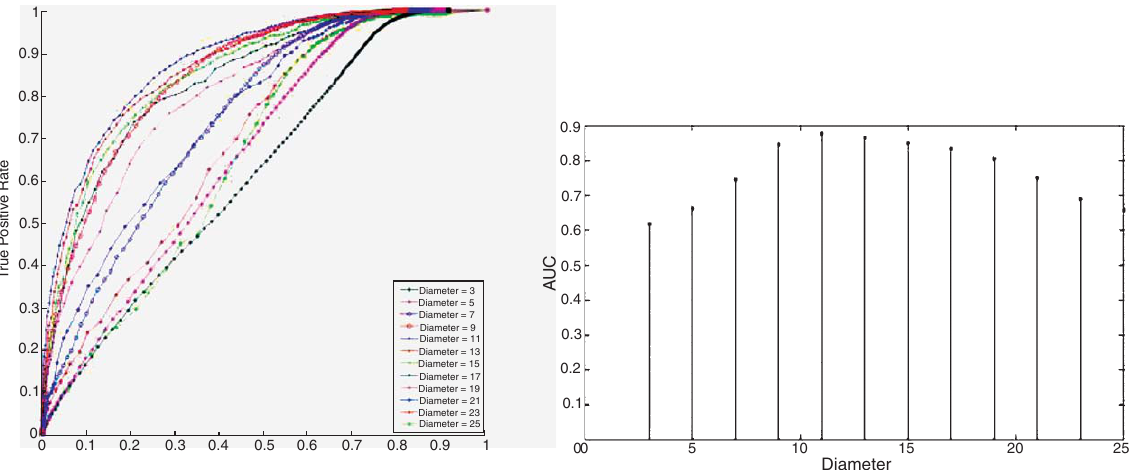
Fig. 8. SIVQ analysis of MPUC and reactive urothelium. Similar to the analysis in Fig. 4, an additional field of view (Fig. 7) was added to the analysis and new ROC curves and AUCs were calculated. There was a very similar pattern with an improvement in performance from 3–11 followed by a degradation from 11–25 (left panel). The right panel shows an improvement in the maximal AUC,